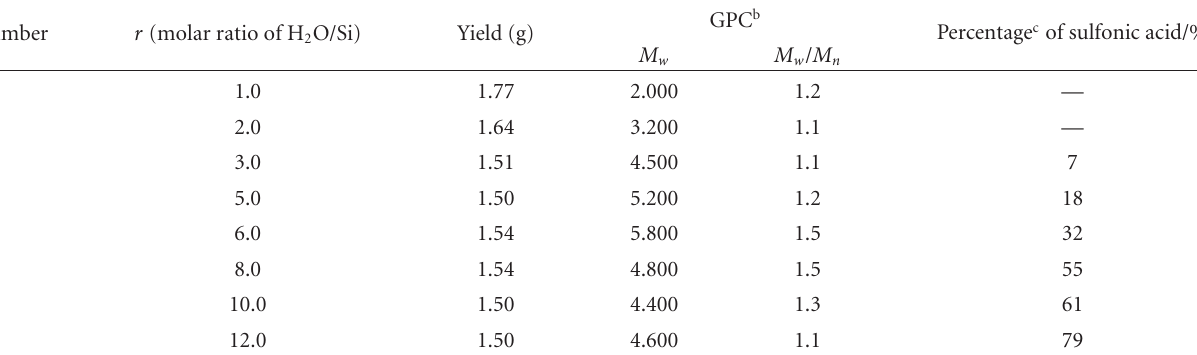
Scheme 1: Schematic figure for the synthesis of SPES. Table 1: Results for the synthesis of SPES a